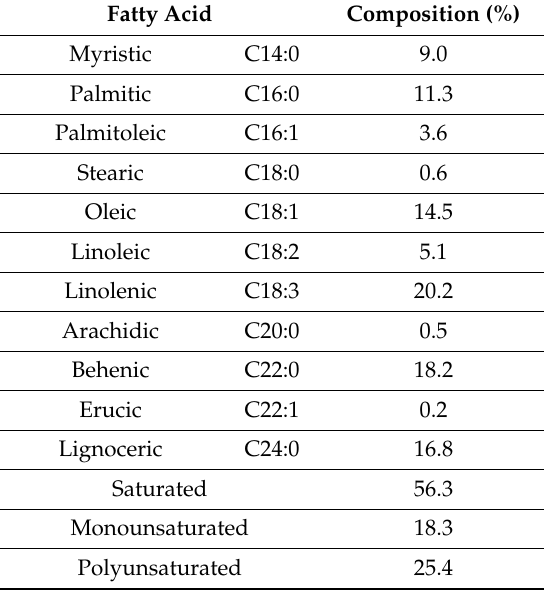
Table 6. Fatty acid profile of FAEEs obtained with combi-lipase 25:75 SBA-15-NH 2 G-CalB:SBA-15- NH 2 G-PC.